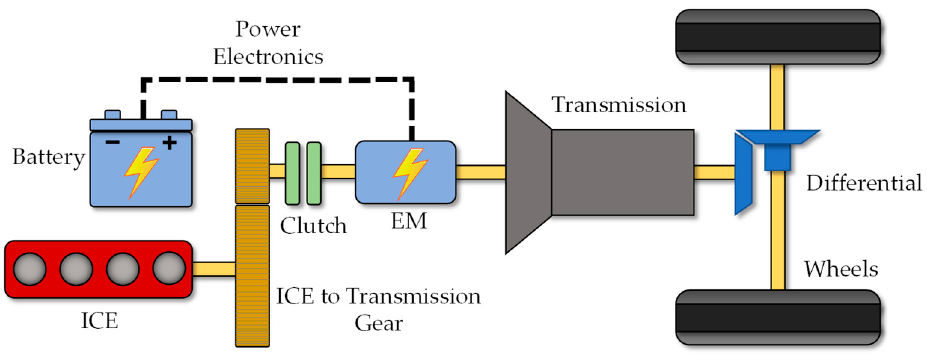
Table 1. Hybrid electric vehicle (HEV) data.